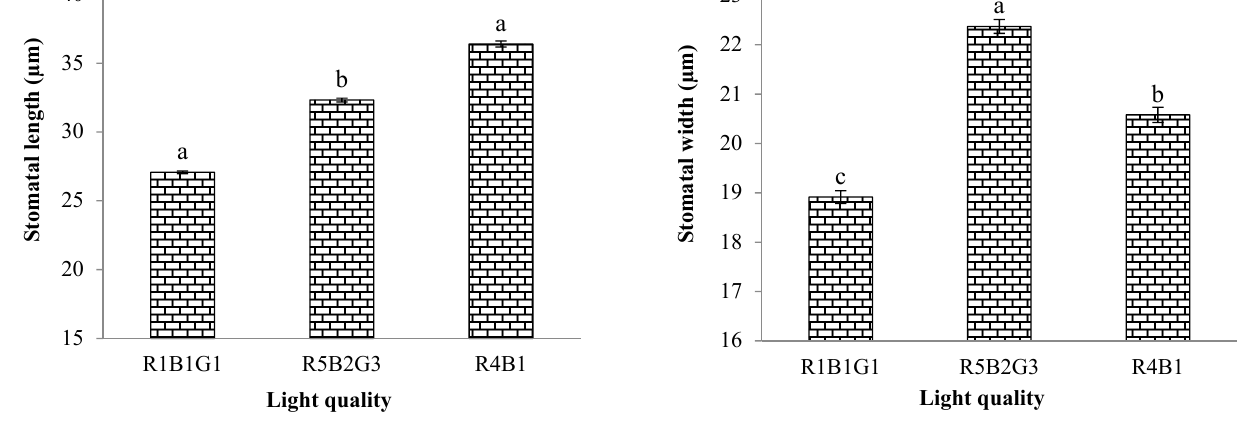
Figure 5. The abaxial epidermis of spinach leaves at different light qualities: ( a ) R4B1, ( b ) R5B2G3 and ( c ) R1B1G1. Scale bar is 50 µm.